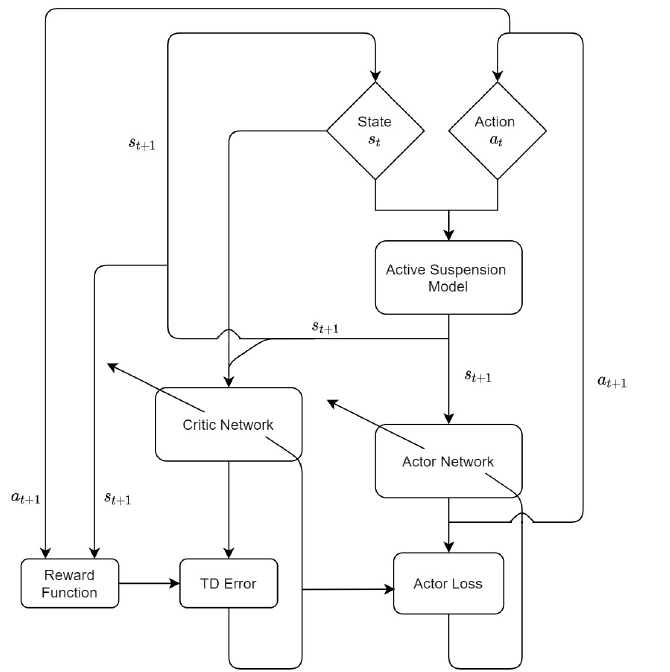
Figure 5. Algorithm